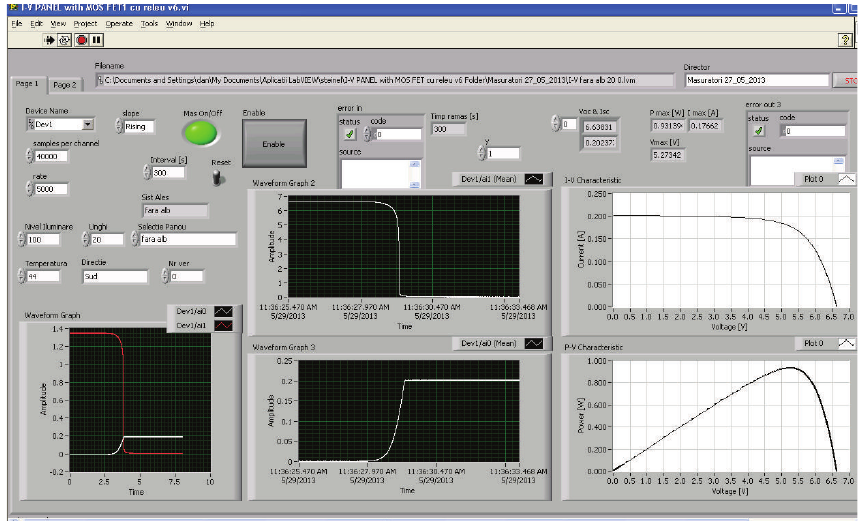
Figure 2: The application to measure the I - V and P - V characteristics of photovoltaic panels.